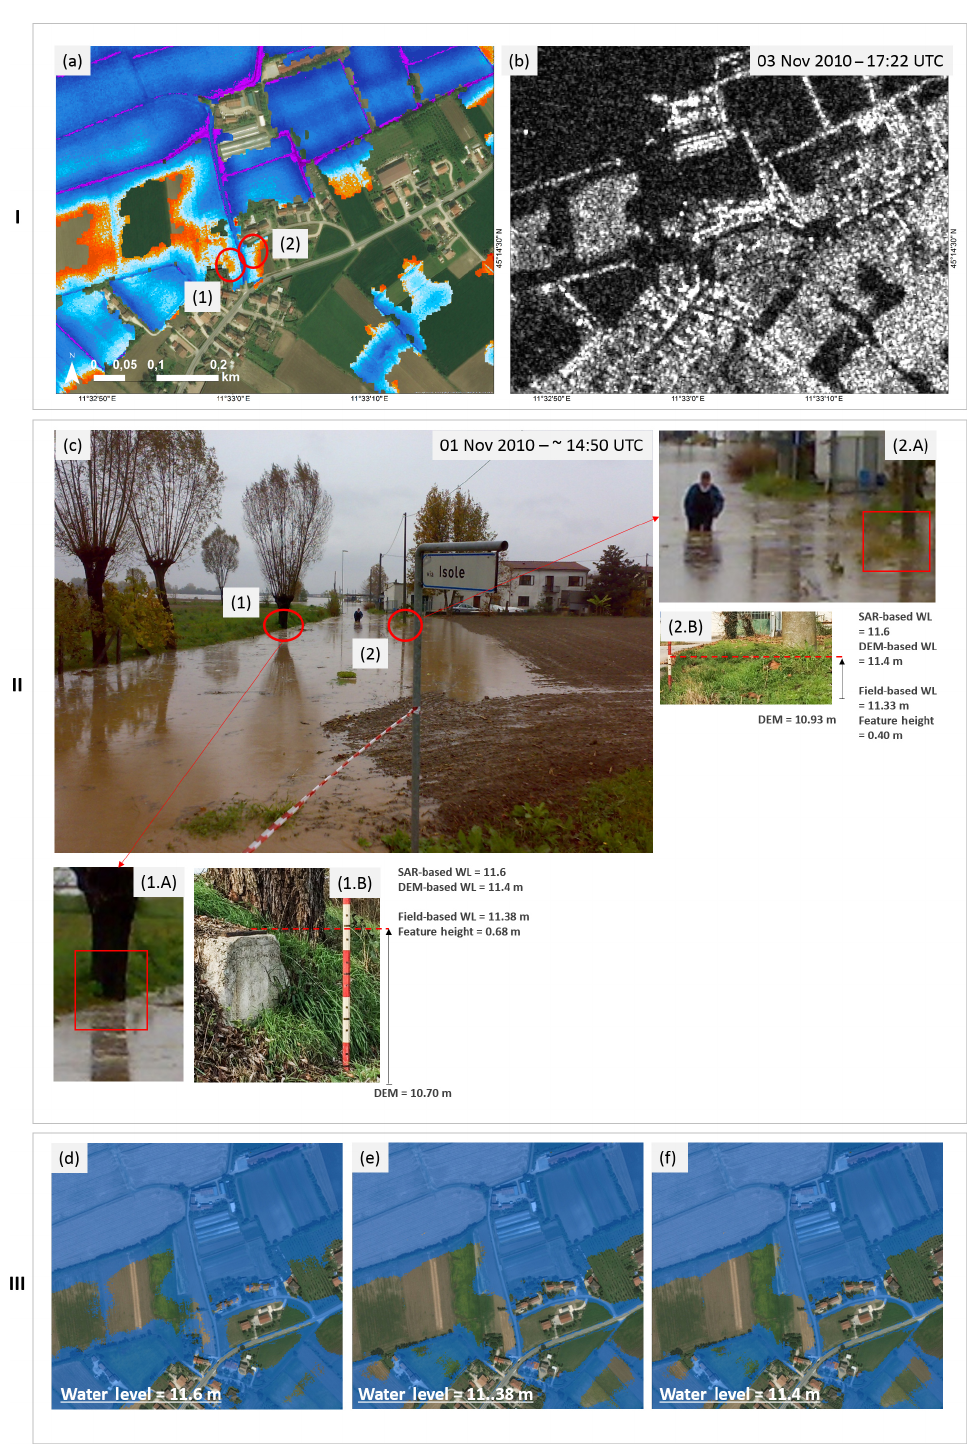
Figure 11. Flood depth on 3 November over Via Isole in the Saletto area of interest; panel I shows (a) flood depth in the area analyzed; (b) CSK image acquired on 3 November at 17:22UTC from where the flood map has been derived; panel II shows (c) an aerial view of the event acquired on 1 November at about 14:50UTC with zooms on two areas (1.A, 2.A) with relative fieldwork images (2.B and 3.B); panel III shows the flood extent derived with the DEM-fill method for different water levels: Fig. 11d with a water level equal to 11.6m corresponding to the elevation estimated by the proposed method; Fig. 11e with a water level equal to 11.38m corresponding to the water elevation estimated by fieldwork for area 1; Fig. 11f with a water level equal to 11.4m corresponding to the level estimated by the DEM-fill method in order to obtain the same flood extent of the aerial